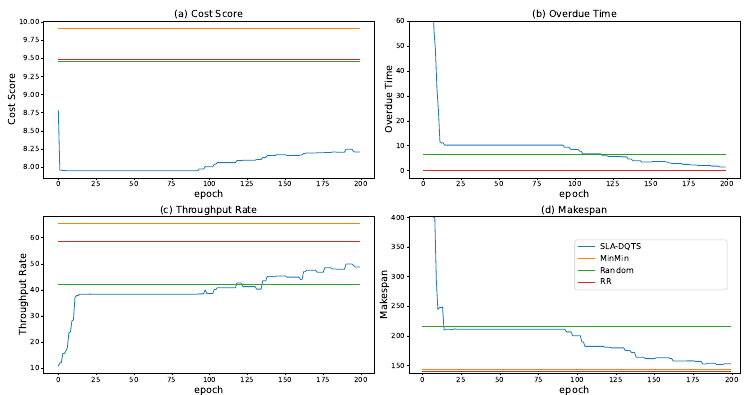
Figure 6. Performance of SAL-DQTS and comparison algorithms under medium-load environment.